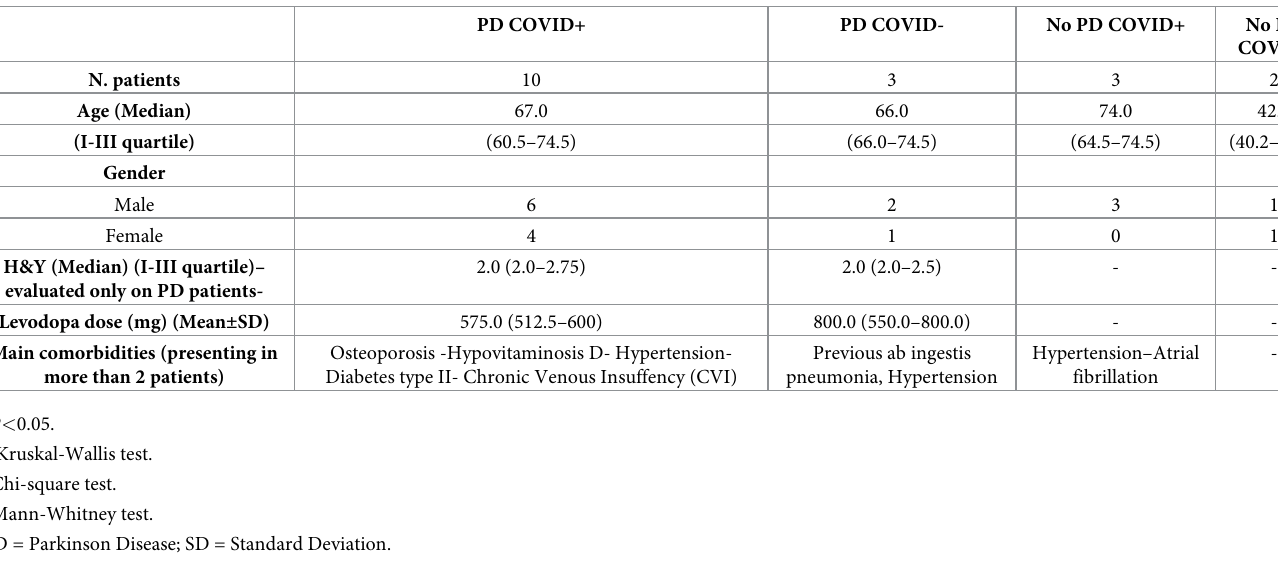
Table 2. Demographic and clinical characteristics of 4 groups (PD Covid+, PD Covid-, No PD Covid+, No PD